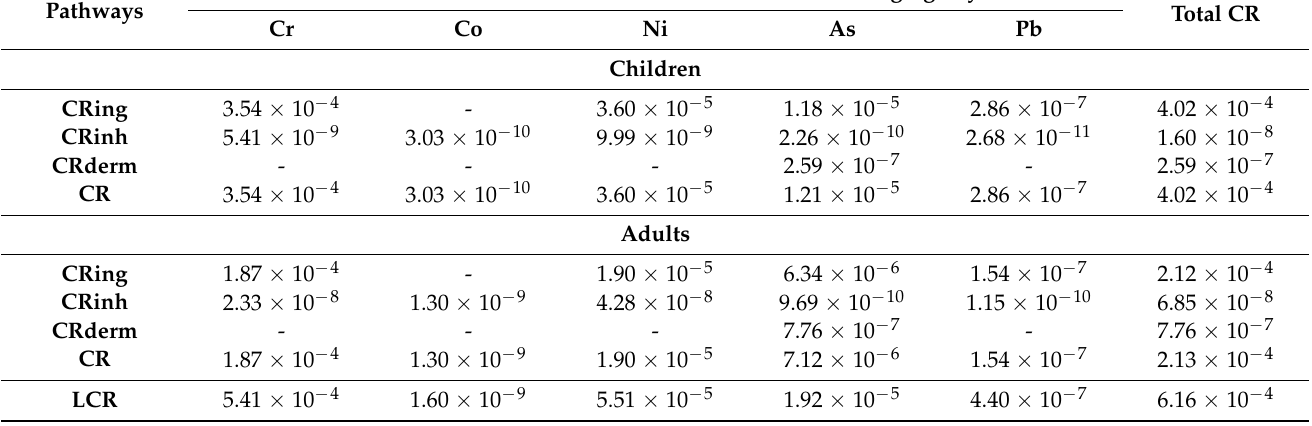
Table 14. Cancer risk assessment for trace elements in road dust via ingestion, inhalation, and dermal exposure pathways for children and